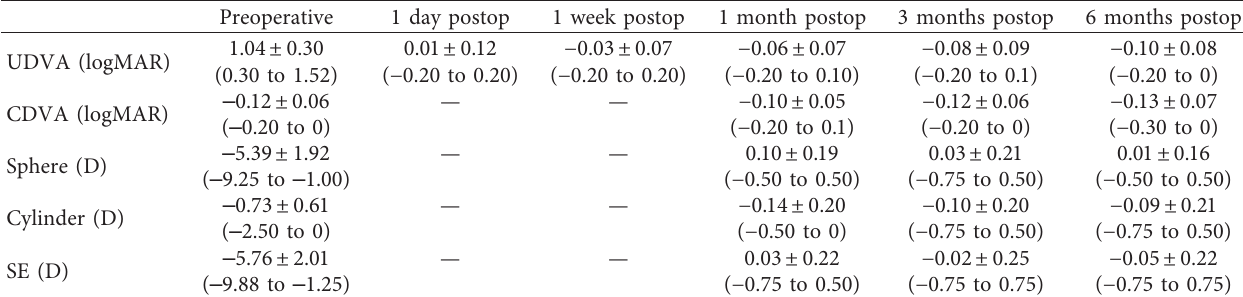
Table 2: Clinical features and refractive outcomes before and after